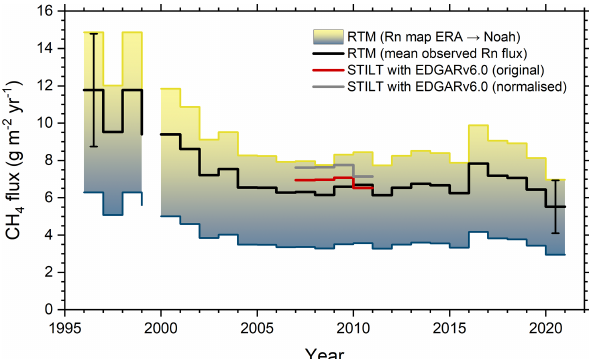
Figure 7. Long-term trend of the RTM-based CH 4 flux in the Hei- delberg footprint. The black histogram (with typical RTM-based uncertainties shown for the first and the last year of observa- tions) was calculated based on the observation-based 222 Rn flux of 18 . 3 ± 4 . 7Bqm − 2 s − 1 . The coloured area shows the range of RTM- based CH 4 flux estimates if either the GLDAS Noah soil moisture (yellow) or the ERA-Interim/Land soil moisture (blue) 222 Rn flux average of the small influence area had been used to calculate RTM- based CH 4 fluxes. Also included in the diagram are RTM-based results from STILT-modelled CH 4 and 222 Rn data for 2007–2010 (based on the slopes in Fig. 8a). The red line shows the original re- sults using the EDGARv6.0 emission inventory and the 222 Rn flux climatology, while the grey line shows the STILT results normalised to the observation-based 222 Rn flux (see